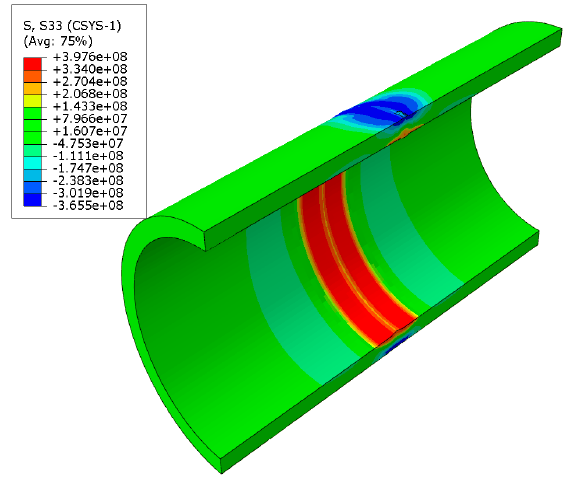
Figure 18. Full-field axial residual stress distributions.